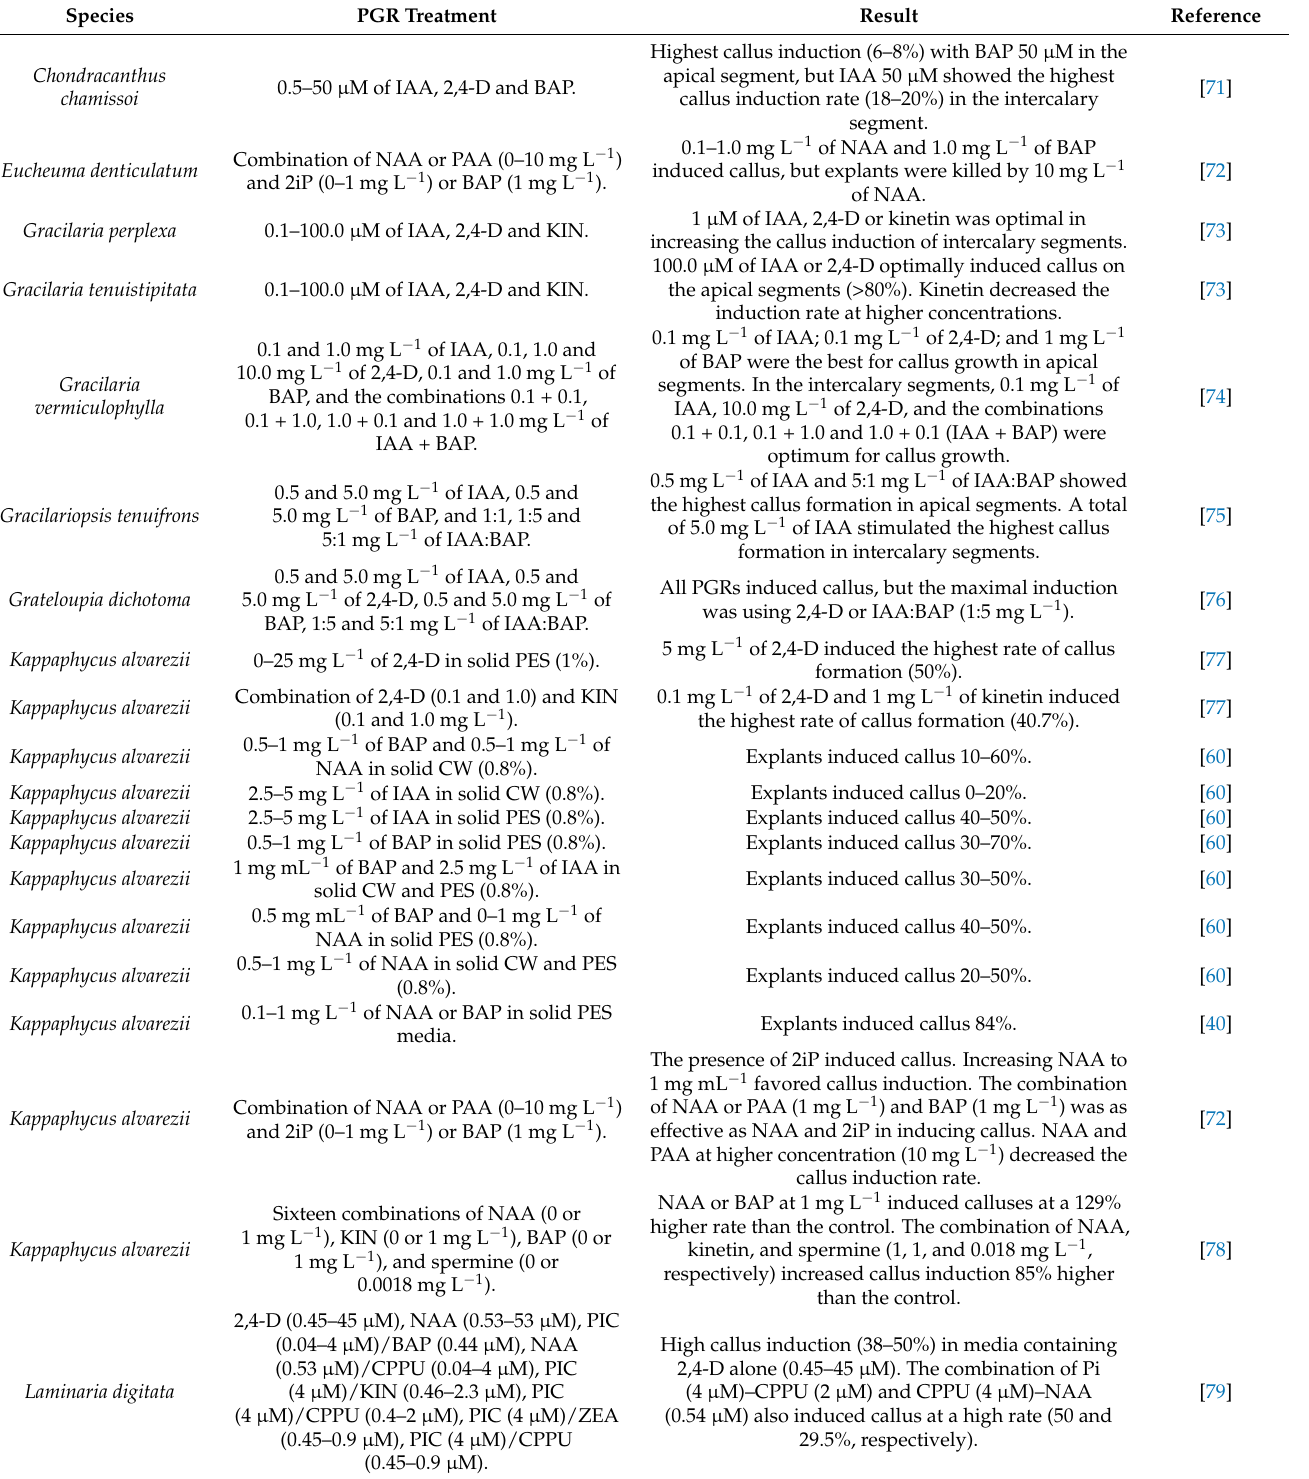
Table 4. Studies on the activity of plant growth regulators on callus induction in